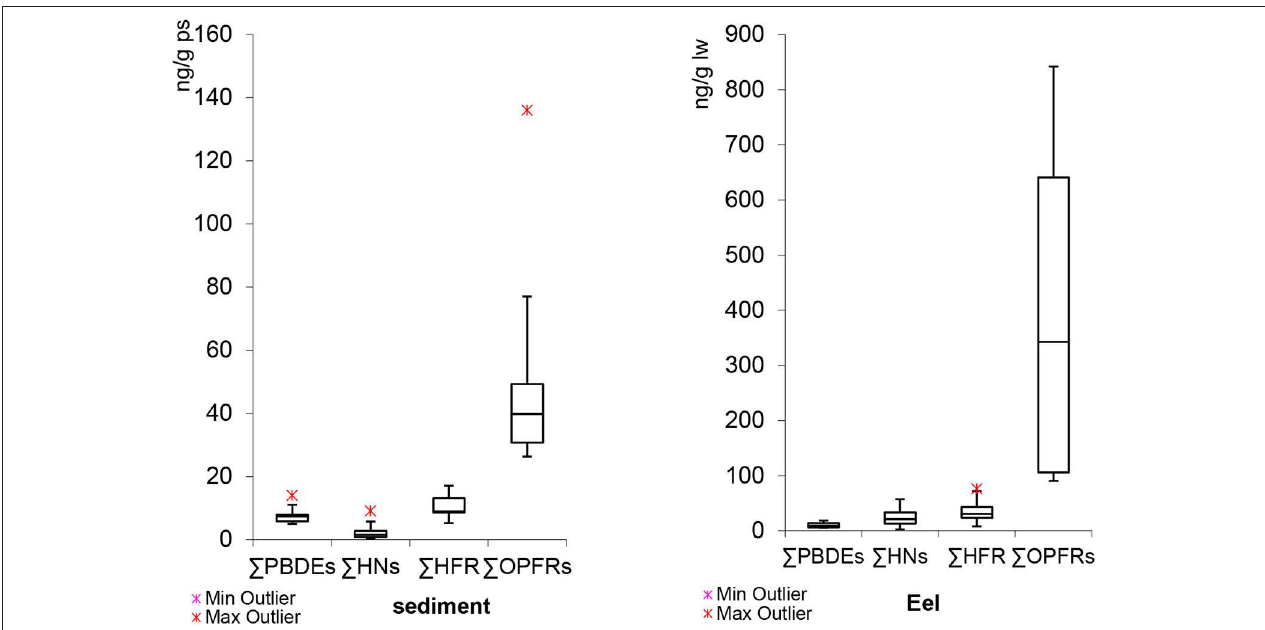
FIGURE 2 | Concentration of FRs in Eels and sediment. Outliers shown ( ×